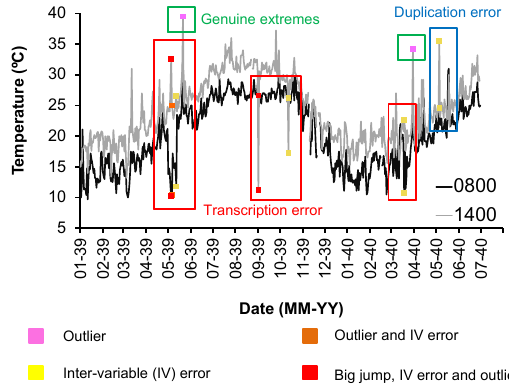
Figure 5. Air temperature evolution (in ◦ C) in Port Said station (Egypt) taken at 08:00 (in black) and 14:00 (in grey) for the pe- riod 1939–1940. Different errors flagged by SAQC are marked with solid coloured squares: an outlier (pink); outlier and inter-variable (IV) error (yellow); IV error (orange); and big jump, IV error and outlier (red). The decision made by manual checking is shown by rectangular outlines: values identified as transcription errors are out- lined by a red border, values flagged due to a data duplication error are outlined in blue, and values that were found to be valid extremes are outlined in green. Values found to be errors were corrected and given a flag of fl12 in the quality-controlled version of the datasets, and values found to be correct were retained and given a flag of